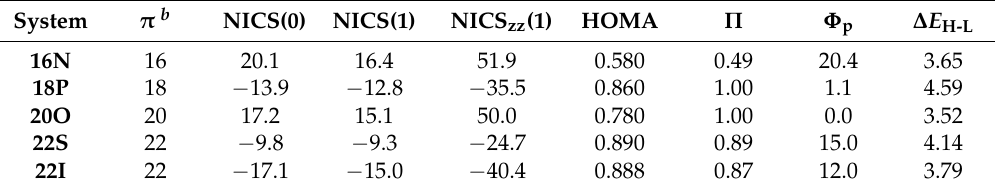
Table 9. Energetic, structural, magnetic properties of selected meso -substituted porphyrinoids a .